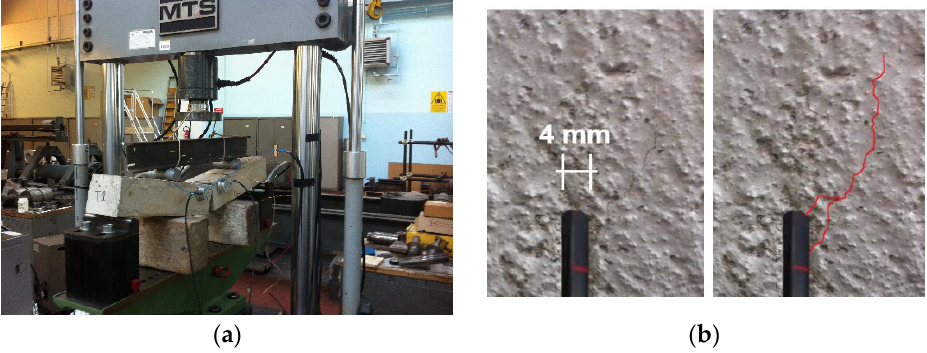
Figure 7. Test 1: ( a ) collapsed specimen and ( b ) particular of the crack developed near the notch. Figure 8a,b shows the load vs. displacement and cumulated AE energy vs. displacement